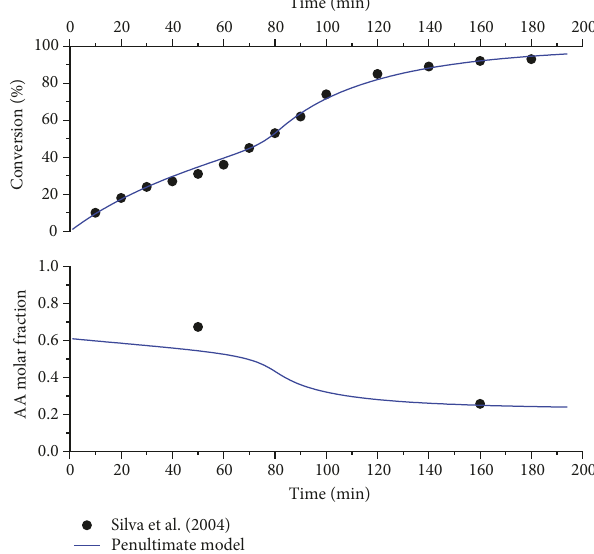
Figure 5: Penultimate model prediction for the vinyl acetate/acrylic acid copolymerization. M = 0 054 , r = 2 927 , r r 11 12 = 1 0 [52]. s 2